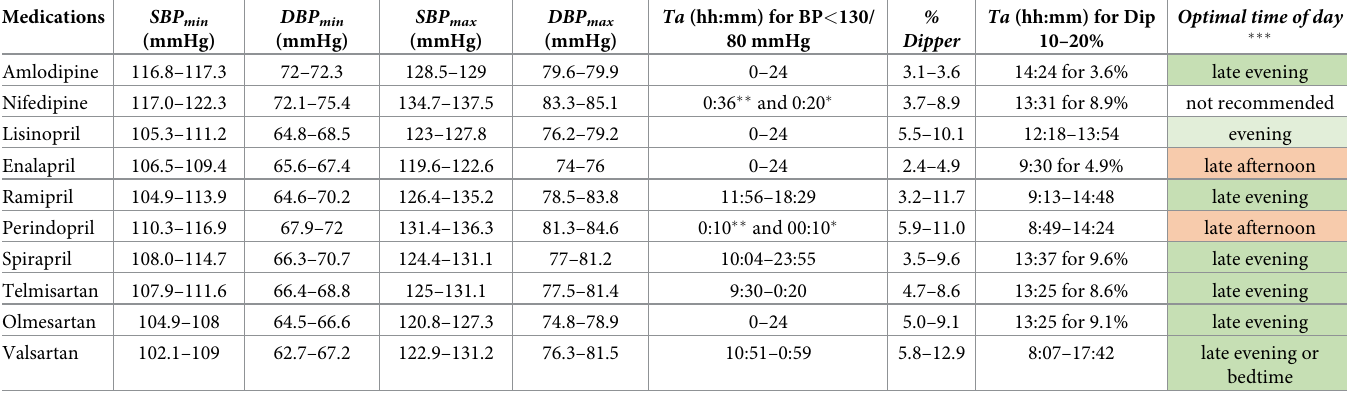
Table 4. Predicted results of BP and optimal dosing times (Ta) after awakening using PK-PD models at different dosing times for non-dipper subjects.